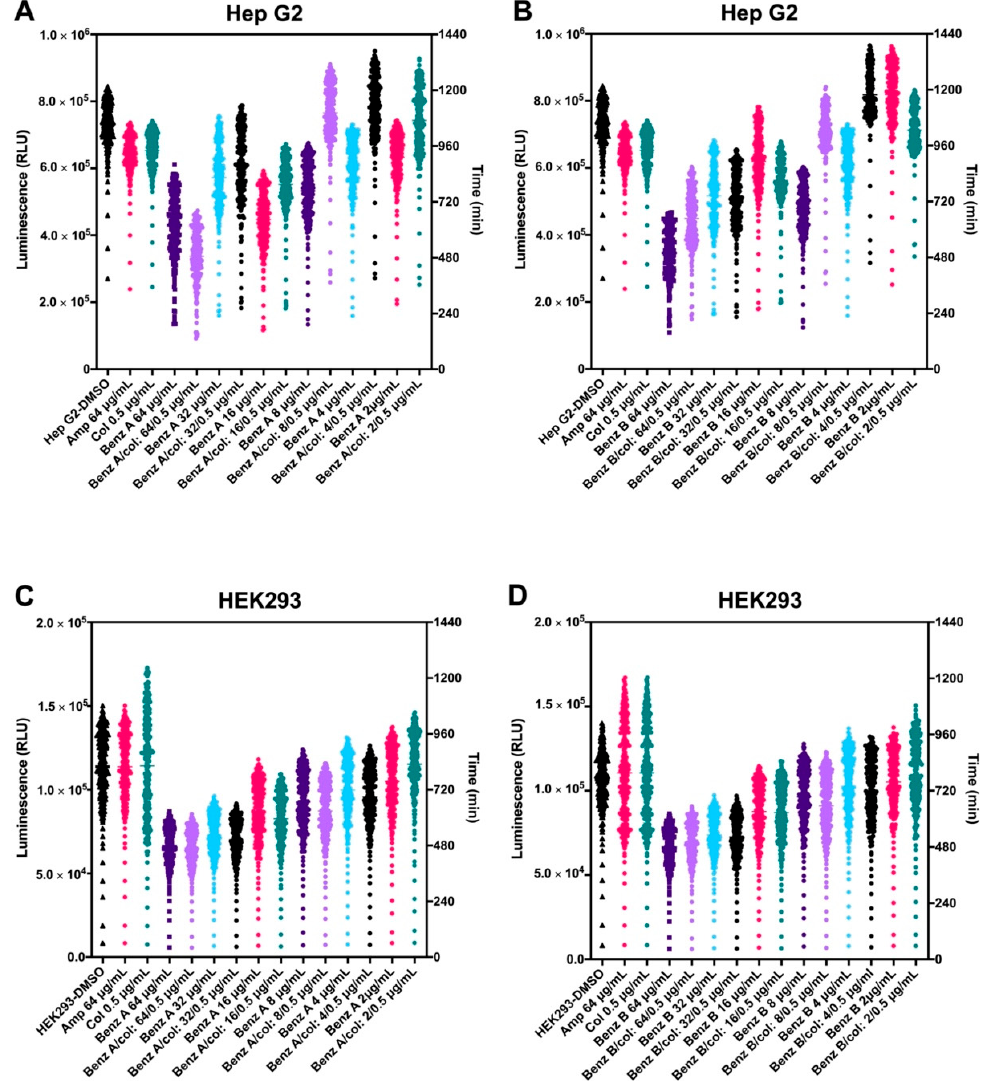
Figure 4. Cytotoxicity assessment of benzguinols A and B alone and in combination with colistin. Real-time cell viability measurements for Hep G2 ( A , B ) and HEK293 ( C , D ) cells after treatment with different concentrations of benzguinols A and B alone and with 0.5 μ g/mL of colistin. The viability of each cell line was measured hourly for 20 h at 37 °C in the presence of 5% CO 2 on a Cytation 5 Cell Imaging Multi-Mode Reader (BioTek, Millennium Science Pty Ltd, Mulgrave, VIC, Australia) using the RealTime-Glo TM MT Cell Viability Assay reagent (Promega, Madison, WI, USA). Data presented are relative light units (RLU) for each treatment per time point. Abbreviations: Amp, ampicillin; Col, colistin; Benz, benzguinol.